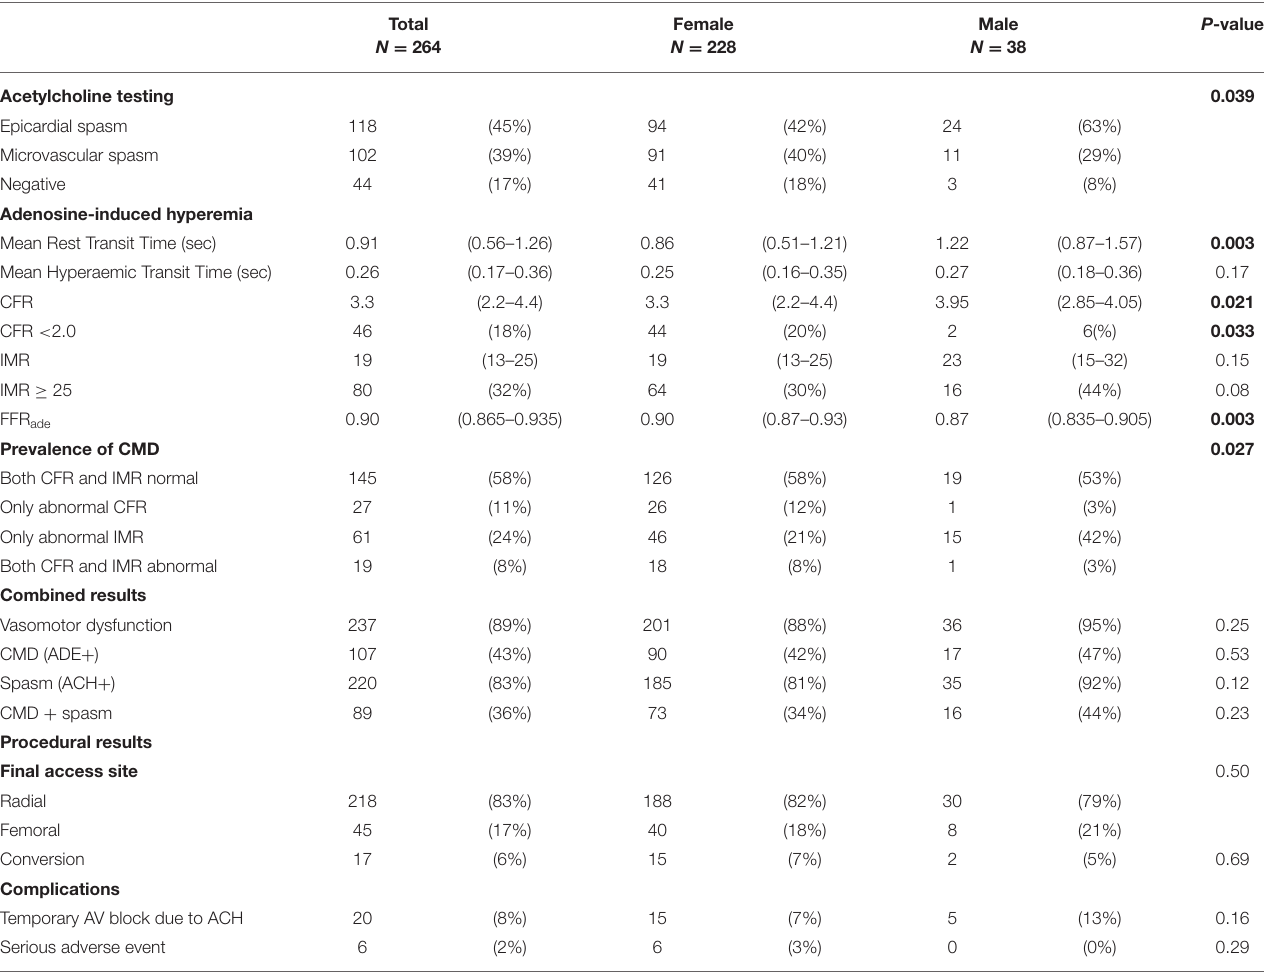
TABLE 2 | Procedural characteristics according to sex.